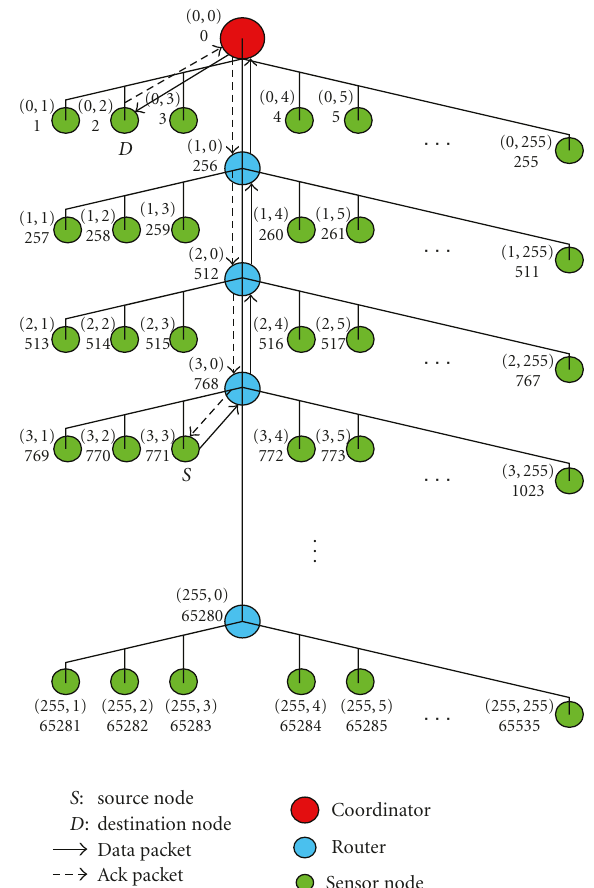
Figure 8: A sample example of a tree-based routing under 2D AACS scheme in a 16-bit